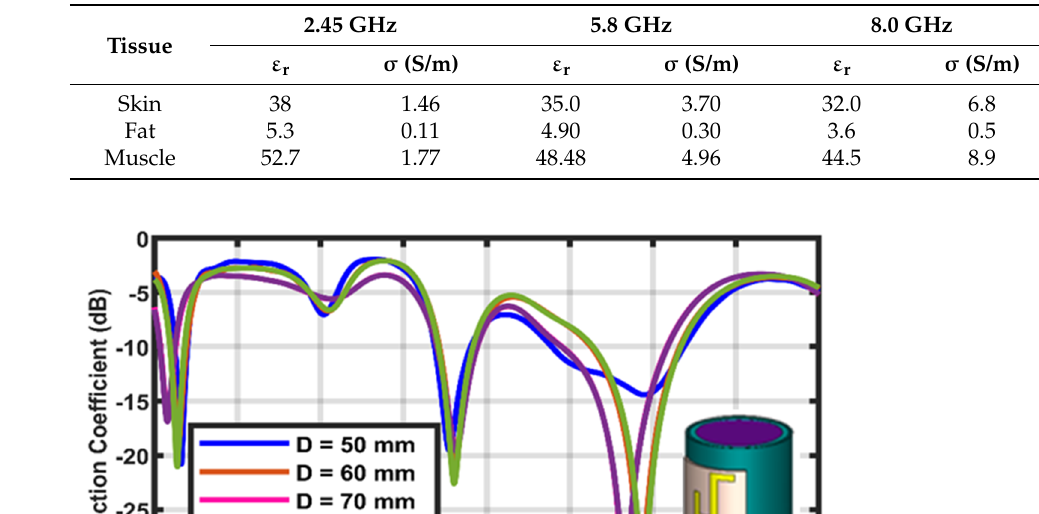
Figure 20. Simulated radiation paern of the antenna in E-plane for various distances at frequencies of ( a ) 2.45 GHz, ( b ) 5.8 GHz, and ( c ) 8.0 GHz. 5.4. Wet Test The performance of the antenna can deteriorate in wet conditions, such as rainy or sweaty environments. To assess its resilience to wet conditions, we added a 1 mm thick layer above the antenna, fully covering its top layer, and filled it with water. We used three different permiivity values of water (80, 76, and 73) to simulate various levels of salt in the water. The results of this test are presented in Figure 21. As shown, the return loss profile of the antenna is significantly distorted due to the coupling of the antenna radiation with the high lossy medium of water. This interaction leads to a considerable amount of scaering of the antenna radiation.